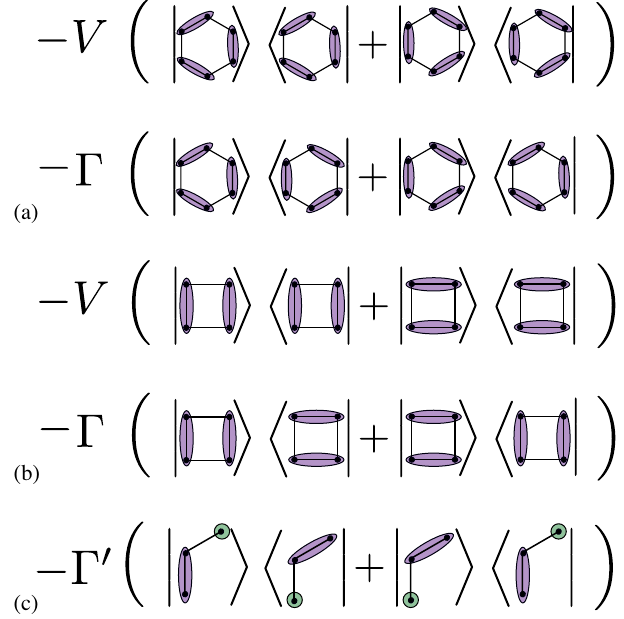
FIG. 4. (a) Potential energy ( V ) and ring exchange ( Γ ) terms on flippable elementary plaquettes in the maximally packed honeycomb-latticequantumdimermodelsofinteresttous.(b)Pote- ntial energy ( V ) and ring exchange ( Γ ) terms on flippable elemen- tary plaquettes in such models on square and cubic